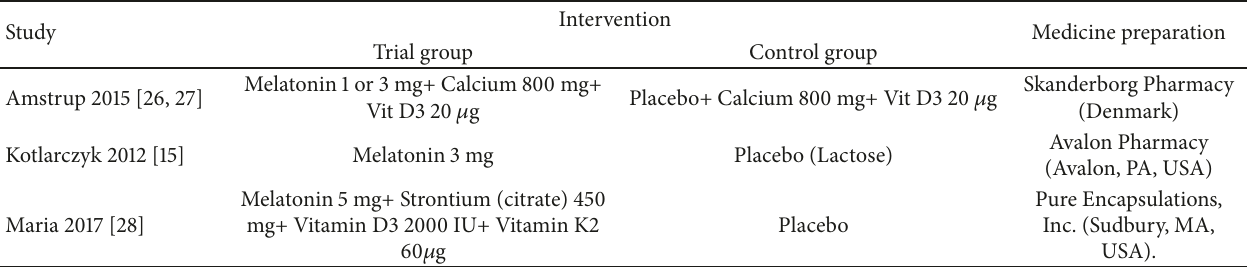
Table 3: Oral supplement